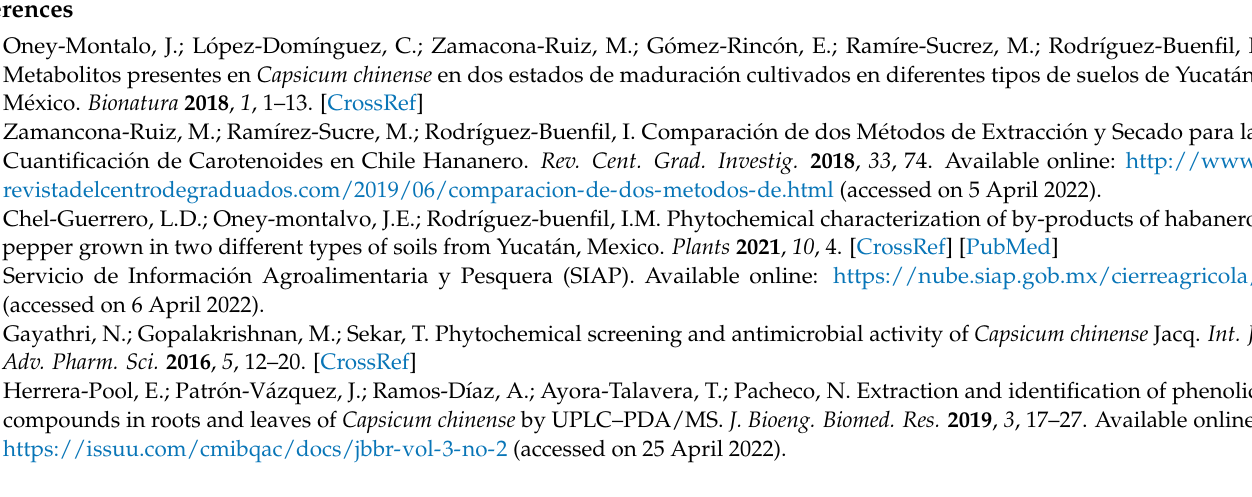
luteolin; 10 = vanillin; 11 = diosmin + hesperidin; 12= neohesperidin, Figure S4. Chromatogram corresponding to Habanero pepper Jaguar leaf extract by MeOH. Numeration: 1 = gallic acid; 3 = catechin; 4 = chlorogenic acid; 5 = cumaric acid; 6 = cinnamic acid; 7 = rutin; 8 = quercetin + luteolin; 9 = kaempferol, Figure S5. Pareto chart of vitamin C, Figure S6. Analysis of total polyphenol content, polyphenol profile and antioxidant activity: Principal component analysis (PCA) depending on variety (a) and cluster of k means depending on variety (b) used. Numeration: 1 = Total polyphenol content; 2 = gallic acid; 3 = protocatechuic acid; 4 = catechin; 5 = chlorogenic acid; 6 = quercetin + luteolin; 7 = rutin; 8 = kaempferol; 9 = neohesperidin; 10 = diosmetin; 11 = vanillin; 12 = cumaric acid; 13 = cinnamic acid; 14 = naringenin; 15 = apigenin; 16 = lutein, 17 = diosmin + hesperidin; 18 = vitamin C, Figure S7. Total polyphenol content (TPC) calibration curve, Figure S8. Chromatogram corresponding to the calibration curve with the polyphenol standards. Numeration: 1 = gallic acid; 2 = protocatechuic acid; 3 = catechin; 4 = chlorogenic acid; 5 = cumaric acid; 6 = cinnamic acid; 7 = rutin; 8 = quercetin + luteolin; 9 = kaempferol, Figure S9. Chromatogram corresponding to the calibration curve with the polyphenol standards. Numeration: 10 = vanillin; 11 = diosmin + hesperidin; 12 = neohesperidin; 13 = naringenin; 14 = apigenin; 15 = diosmetin, Table S1. Statistical analysis of extracts polyphenol profile obtained from the habanero pepper ( Capsicum chinense Jacq.) by-products, Table S2. Equations derived from the linear regression of the individual polyphenols, vitamin C, lutein and the TPC with antioxidant